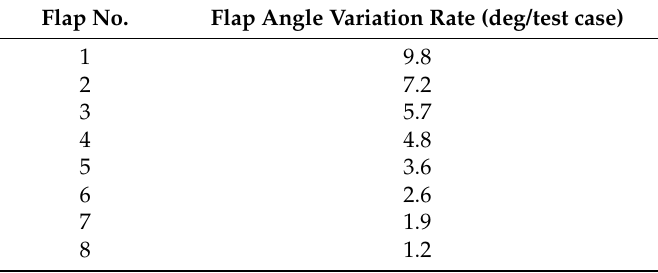
Table 4. Flap angle variation rate for “random” test